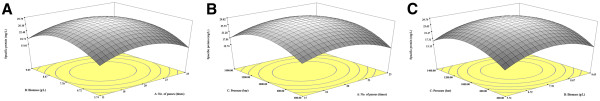
Response surface 3D contour plots of the combined effects of (A) Number of passes and Biomass concentration; (B) Number of passes and Pulse pressure and (C) Biomass concentration and Pulse pressure on specific protein release of HBsAg from cell disruption ofP. pastoriscells.